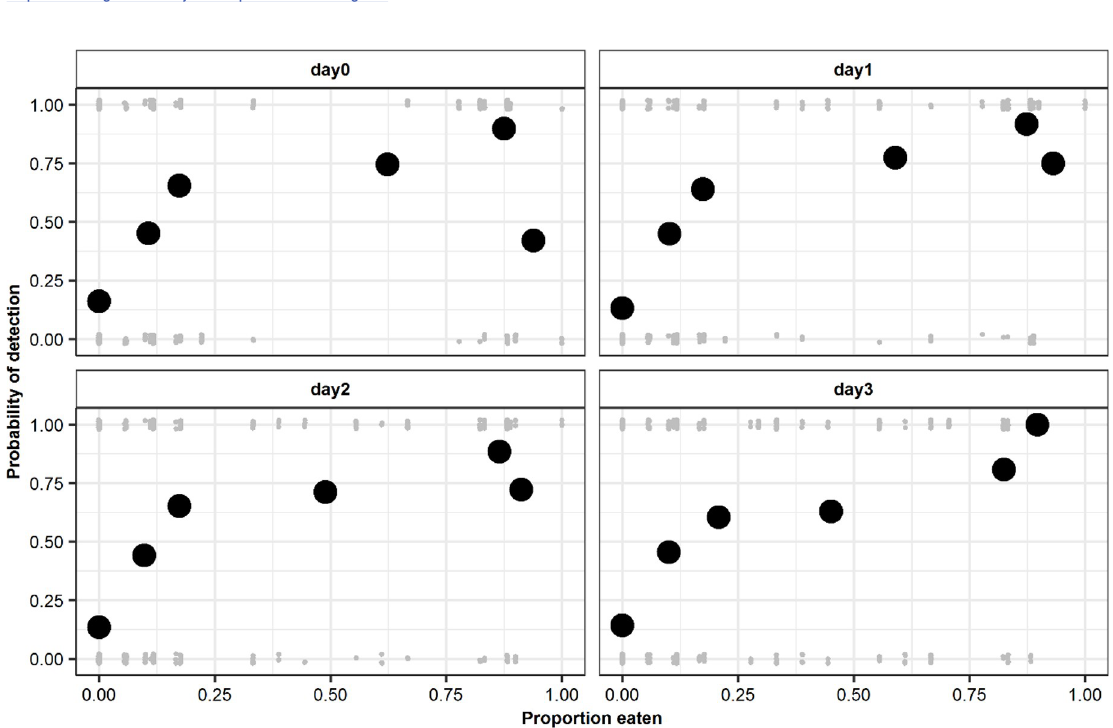
Fig 3. Probability of prey detection as a function of meal size. The grey dots at 0.00 and 1.00 indicate absence or presence of detection of prey items respectively, and the black circles shows the proportion of prey detection relative to proportion fed.